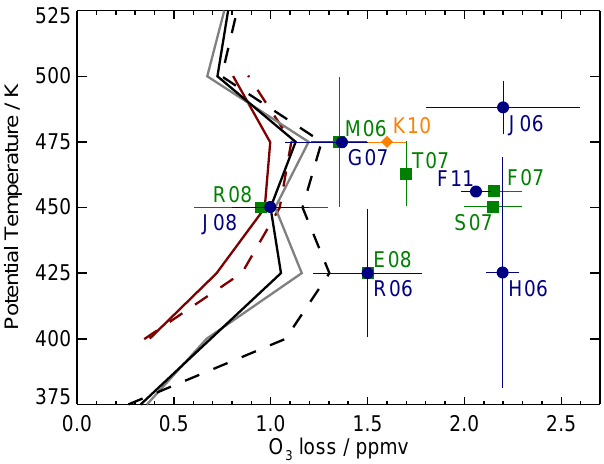
0.0 Figure 5. Vortex average ozone loss from 1 January to 1 April 2005, computed using our method with the “standard” criteria (black solid line) and computed using only those observations more deeply within the polar vortex (sPV ≥ 1 . 6 × 10 − 4 s − 1 , black dashed line), along with comparable estimates from Brakebusch et al. (2013), upon whose Fig. 11 this plot is based (we repeat their “inferred” rather than “modeled” results, shown here by the red solid and dashed lines, using the same vortex edge criteria as for MLS). Also shown are the MLS results using the “stricter” PV variability crite- rion (grey line) and, as in the Brakebusch figure, results from other studies (green, blue and orange symbols) listed in Table 1, with col- ors used simply to aid distinction between results (the Kuttippurath et al., 2010, result is singled out in orange as it did not feature in the Brakebusch